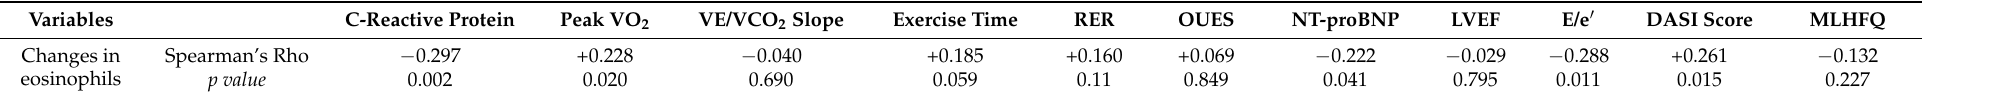
Table 2. Correlations between changes in eosinophils and peak VO 2 , DASI score, C-reactive protein, NT-proBNP, and E/e (cid:48) in patients with heart failure treated with